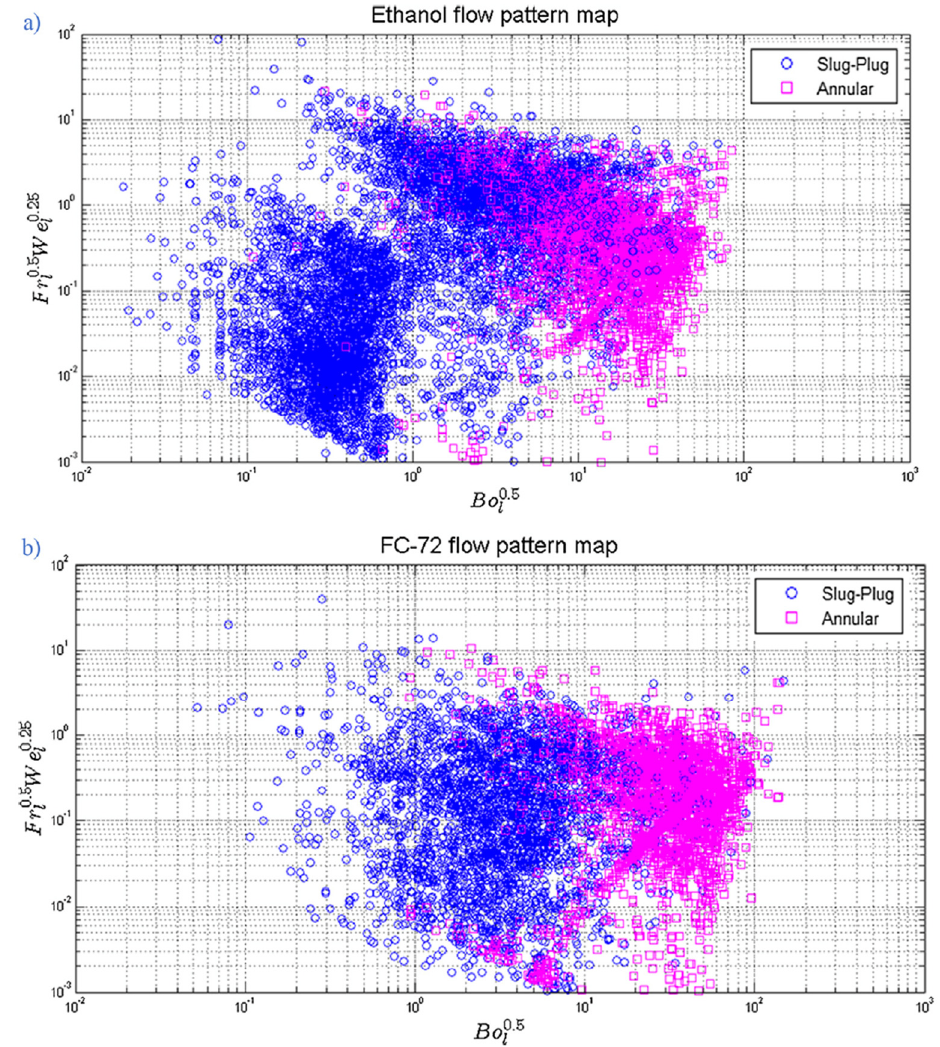
Figure 6. Flow pattern maps for ethanol ( a ) and FC-72 ( b ) proposed by Pietrasanta et al. [29]. Reproduced with permissions.